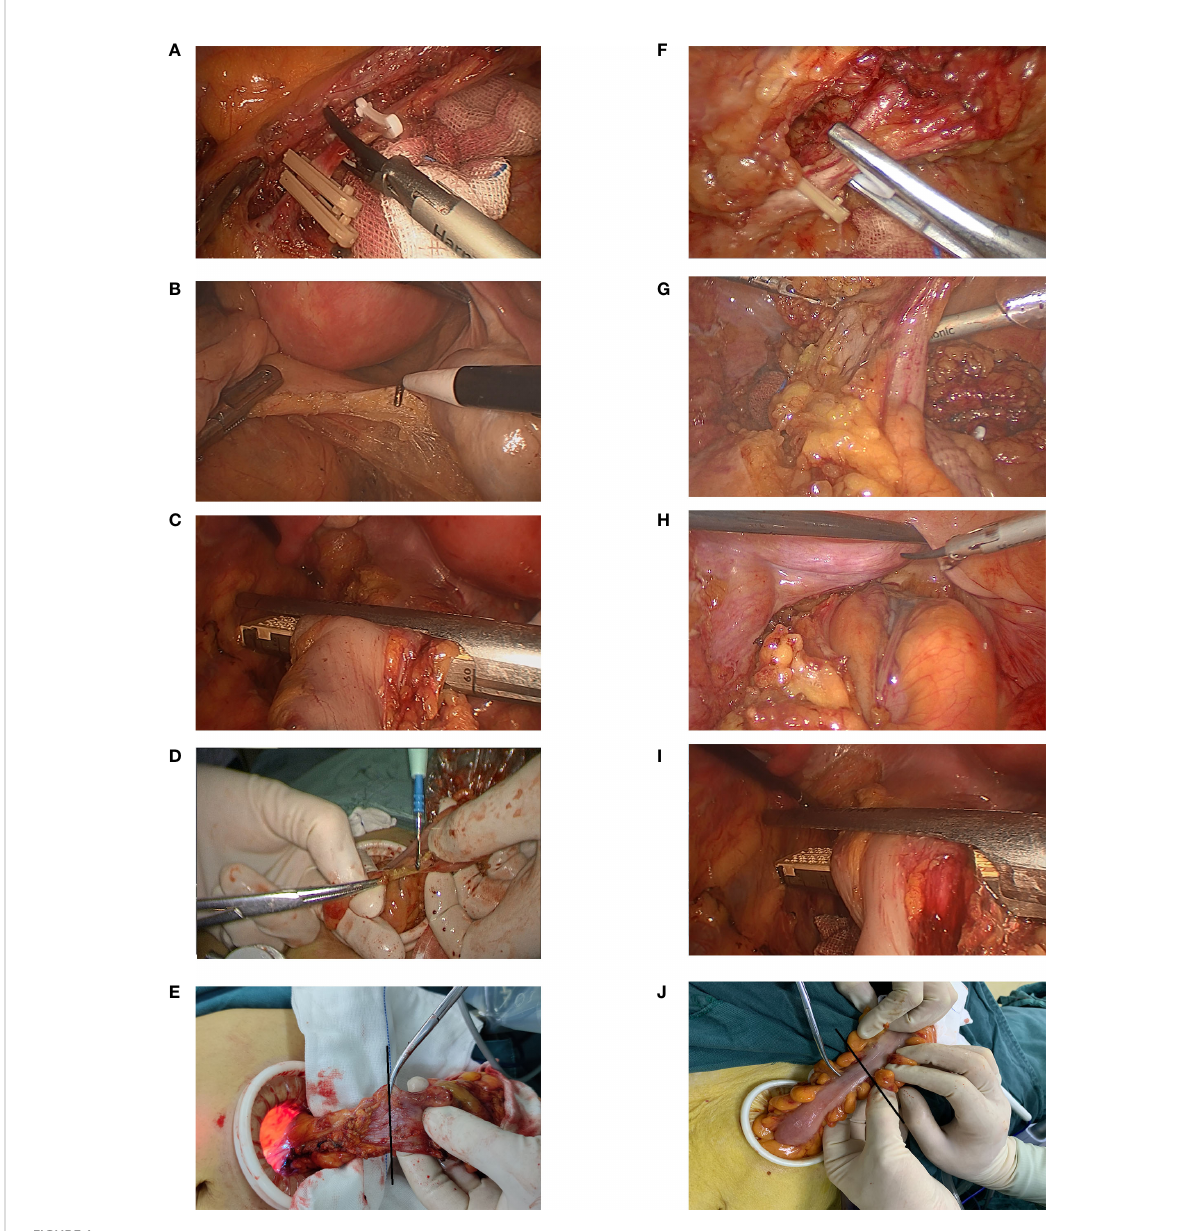
FIGURE 1 Surgical procedure. In the non-PDM group, surgical procedures included (A) ligation of the inferior mesenteric artery proximal to its origin. (B) After separating the distal rectum, (C) the anal side of the rectum was transected and the specimen was extracted through the abdominal incision. After (D) dissection of the mesentery at the level of planned transection (black line), (E) Vascular perfusion was observed. In the PDM group, (F) the inferior mesenteric artery was ligated proximal to its origin. (G) the mesentery of the intended transection site with a length greater than 3 cm was separated. After (H) separating the distal rectum, (I) the anal side of the rectum was transected. (J) The vascular perfusion was observed at the level of planned transection (black line) after the specimen was removed from the abdominal